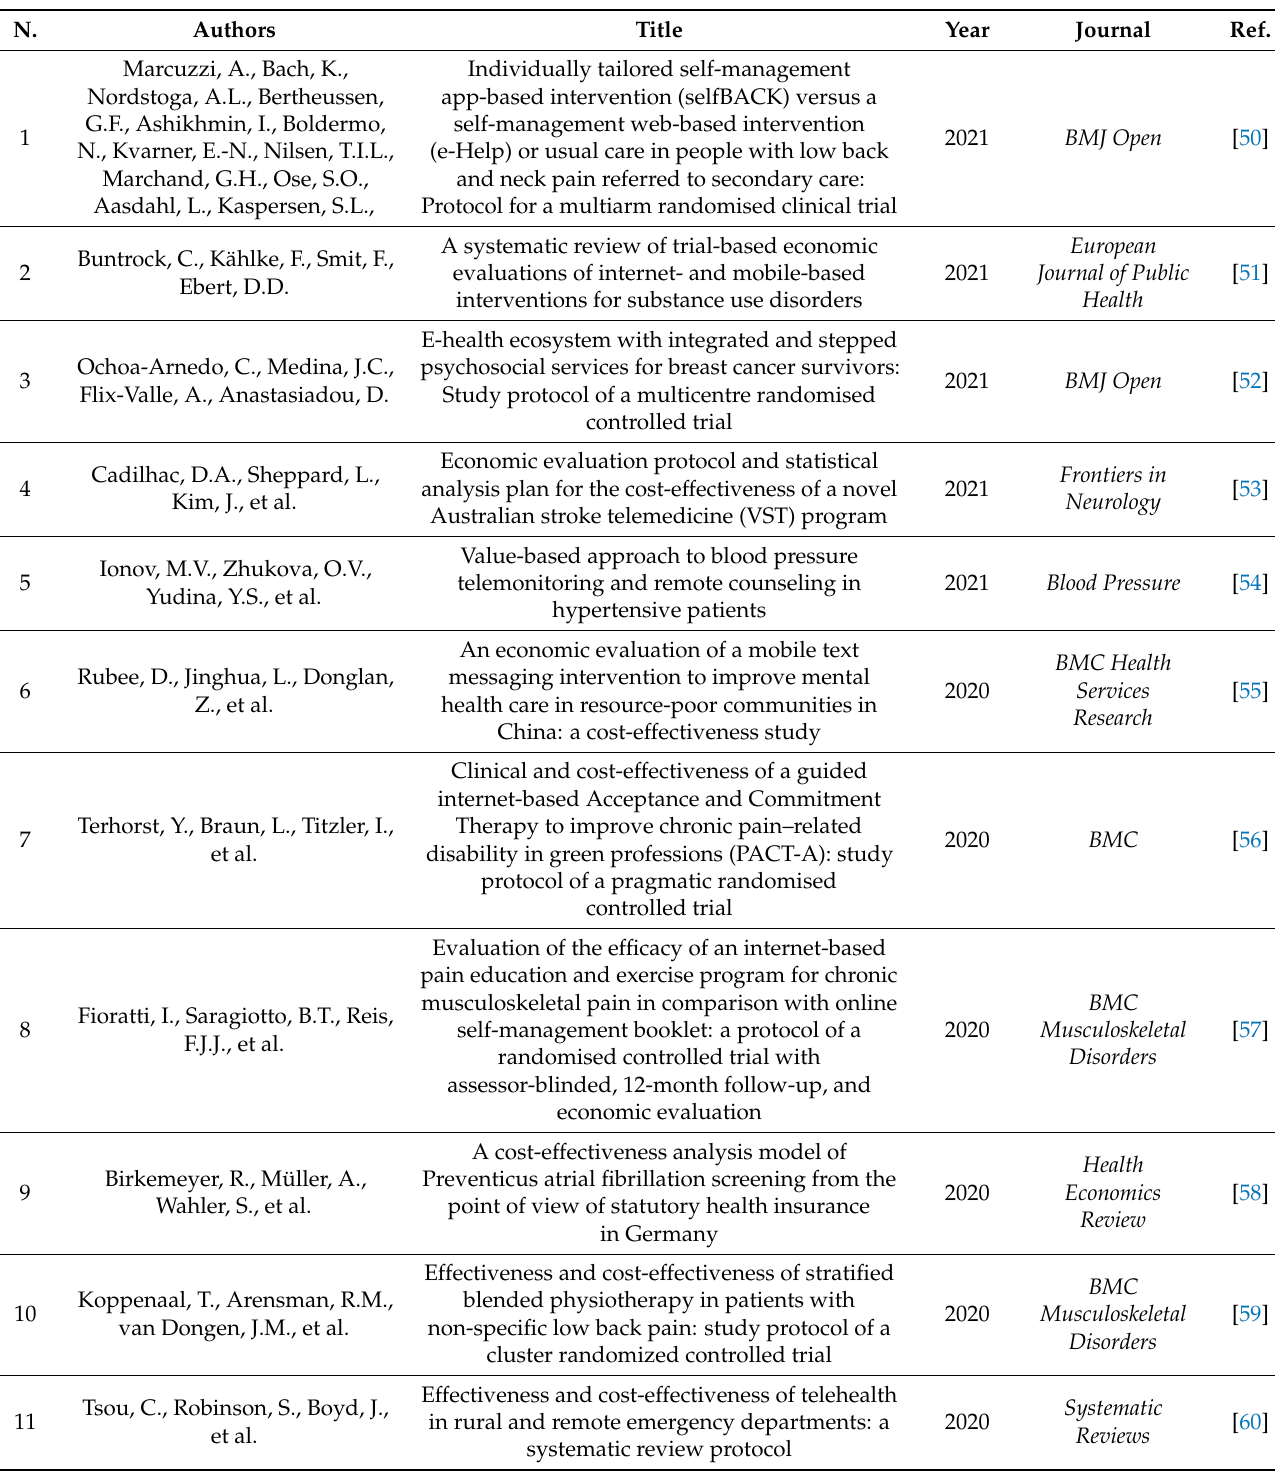
Table 1. Articles analyzed and